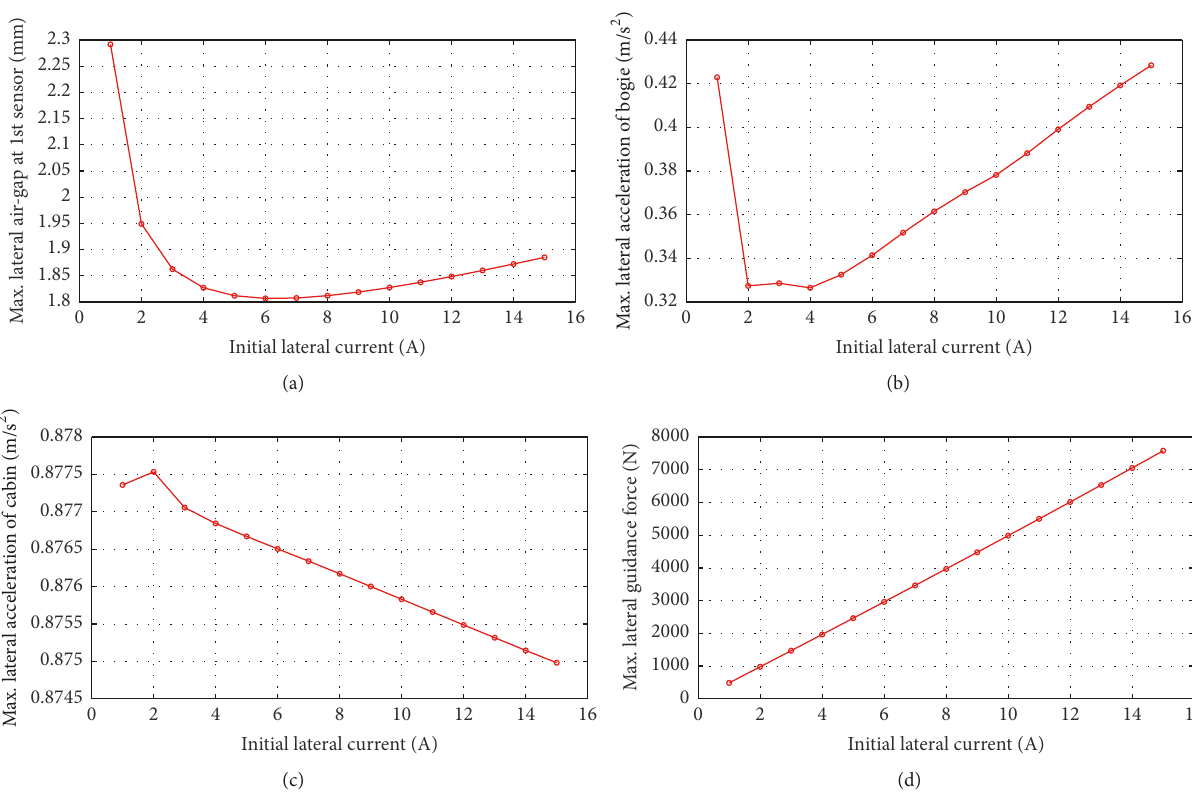
Figure 11: Maximum responses of maglev vehicle against increasing lateral initial current: (a) lateral air-gap at 1st sensor, (b) lateral acceleration at center of cabin, (c) lateral acceleration at center of cabin, and (d) lateral guidance force at 1st electromagnet of 1st bogie.